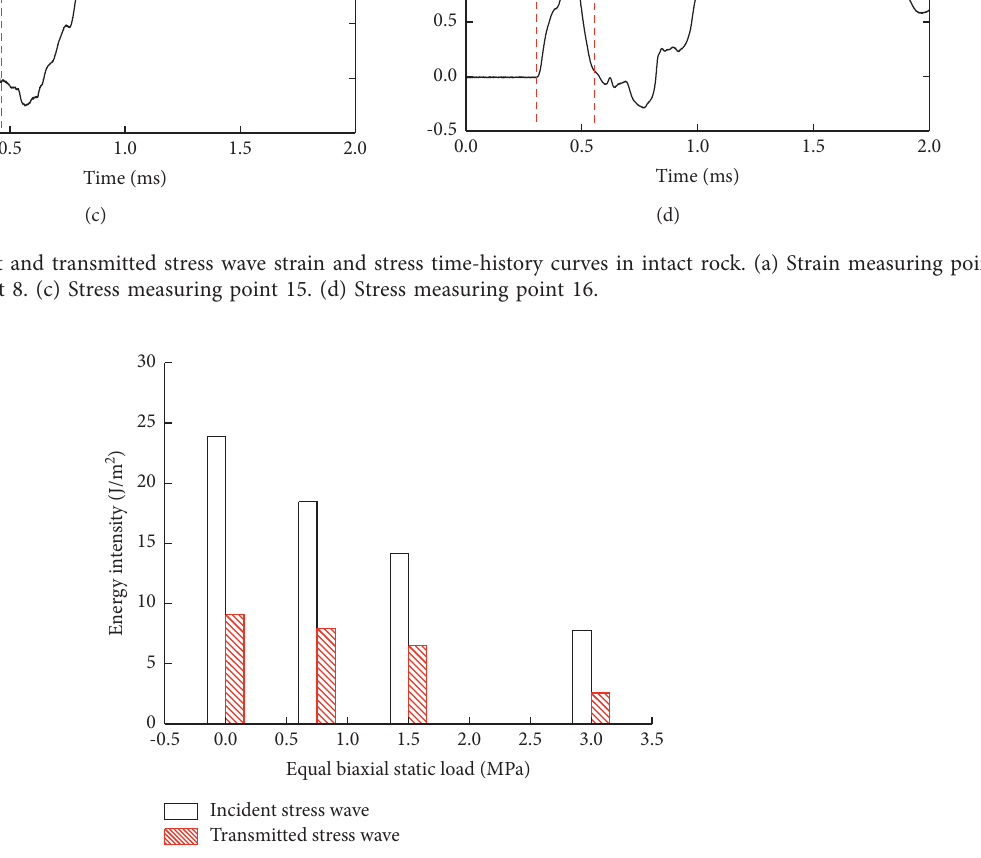
Figure 9: Energy intensities of incident and transmitted stress wave in intact rock under different equal biaxial static